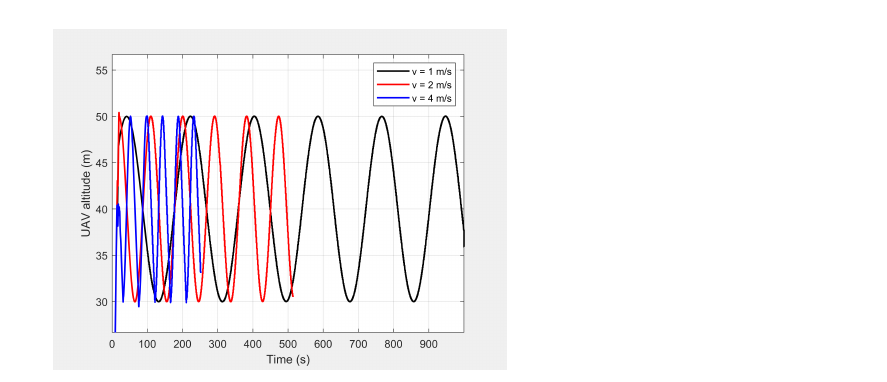
Figure 10. Altitude of the UAV’s planned path when following the MGV while moving at different constant velocities.